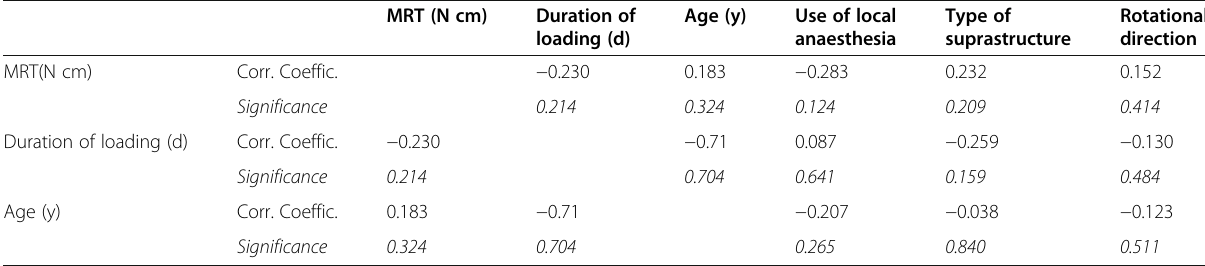
Table 3 Table of